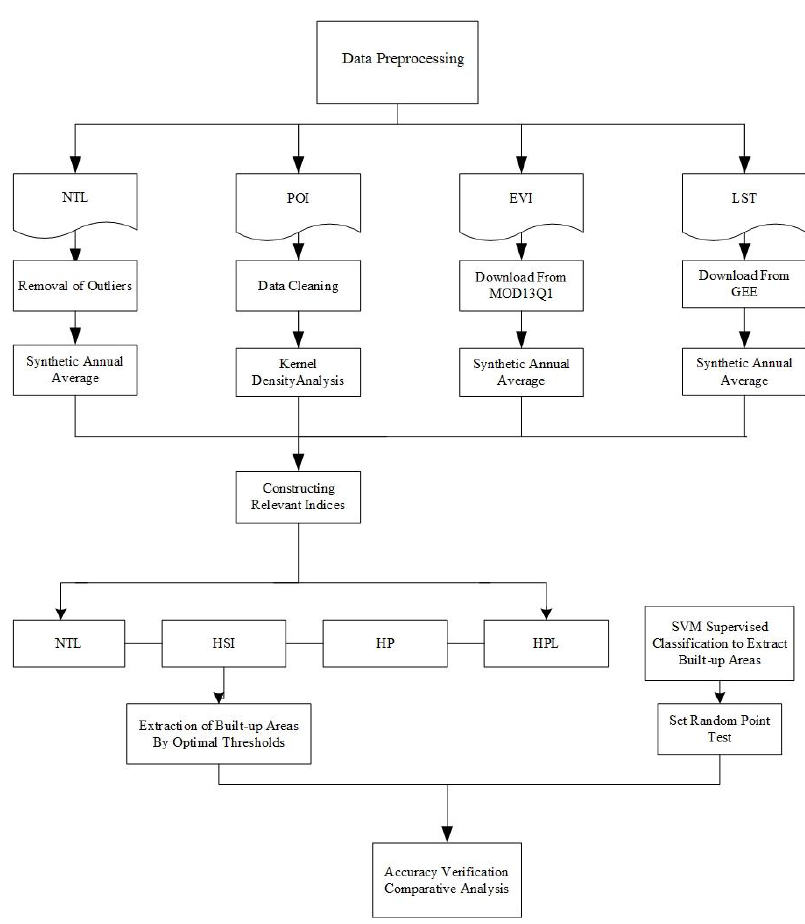
Figure 4. The Flow Diagram of the